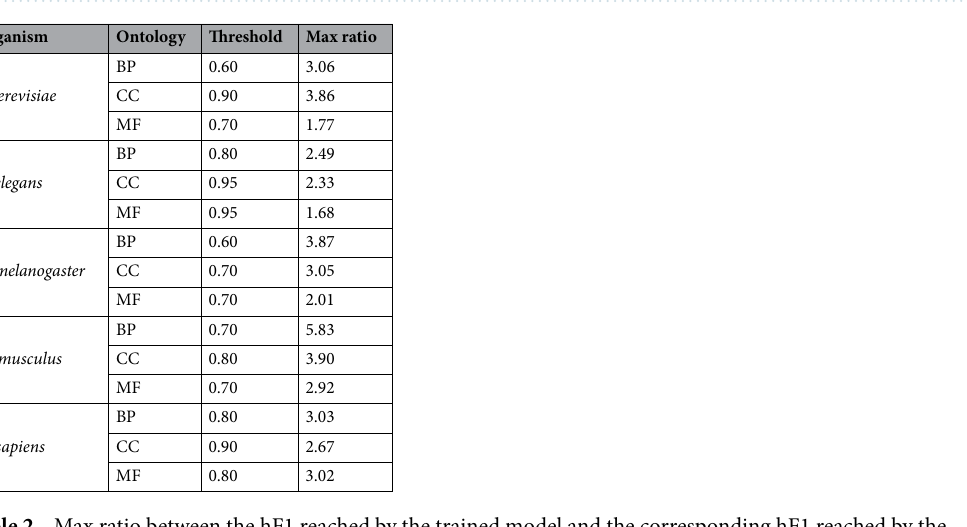
Figure 5. Ratio between the hF1 score of the trained model and the hF1 score of the corresponding random model as a function of the classification threshold. Each graph shows the results for a given organism, representing each ontology with a different color.